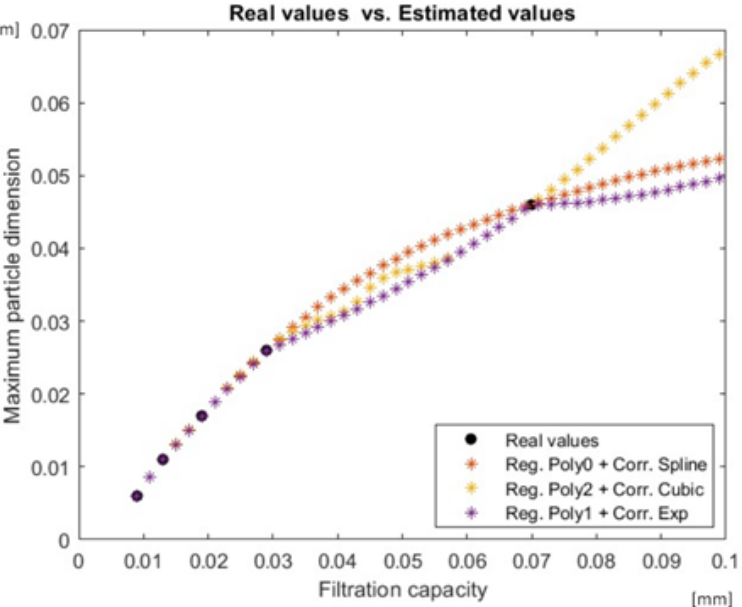
Figure 7. Estimated values using a model with a polynomial regressions and correlation models.